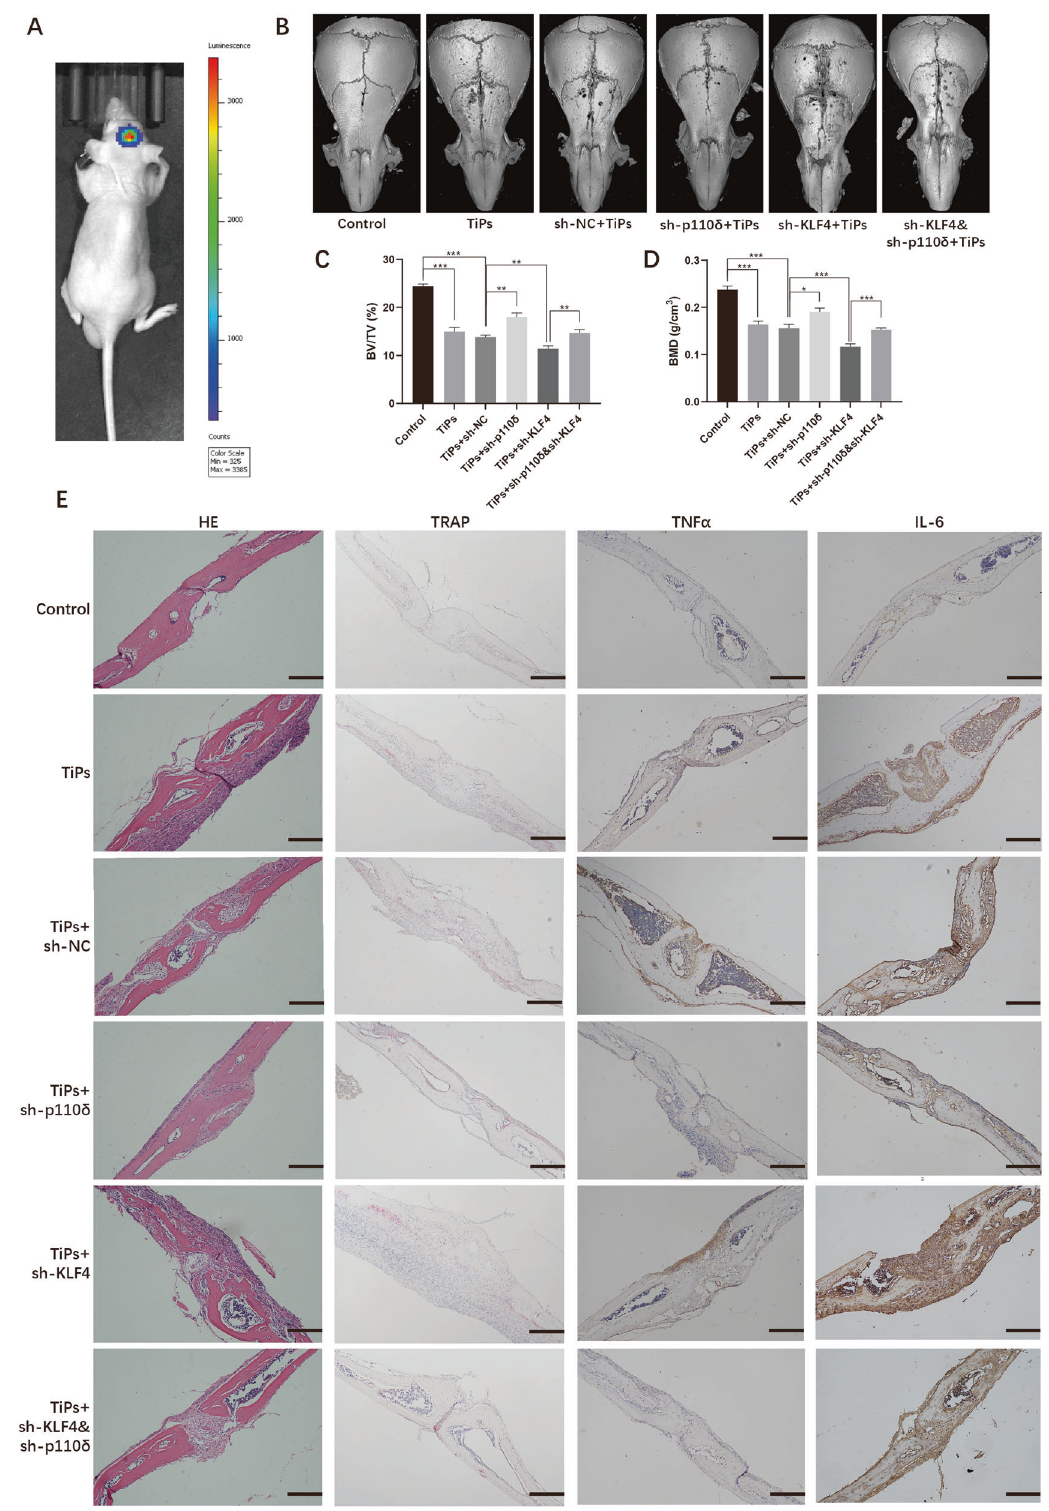
Fig. 7 Knockdown KLF4 exacerbated TiPs-induced osteolysis which was attenuated by knockdown p110 δ . A Noticeable bioluminescence signal from calvarias was detected 7 days after surgery. B 3D construction was implemented and representative images of calvarias from each group were listed after micro-CT imaging. C , D Bone mineral density (BMD) and the ratio of bone volume against total volume (BV/TV) from each group were calculated after 3D construction. E Sections loading calvarias from each group were performed H&E staining, TRAP staining and IHC staining of TNF α and IL-6. The black bar, 200 μ m. Statistic data were displayed as mean ± SEM and were conducted one-way ANOVA analysis to determine signi fi cant difference. * p < 0.05, ** p < 0.01, *** p < 0.001 compared with the negative group.